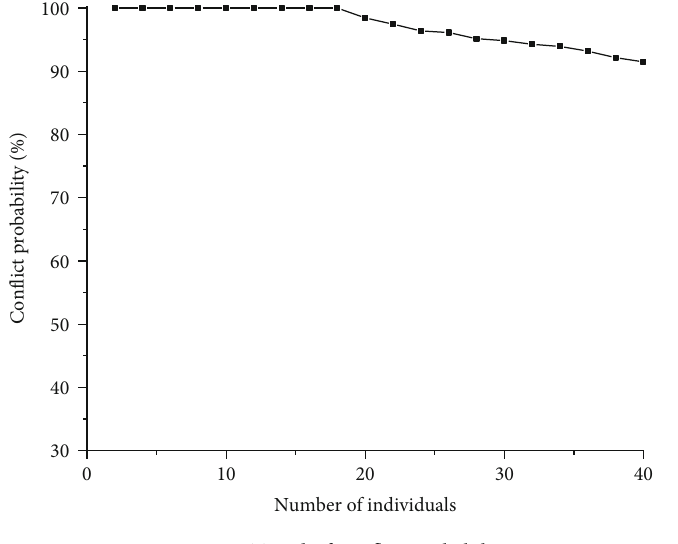
Figure 14: Trend of con fl ict probability. Table 3: Performance comparison of the two resolution